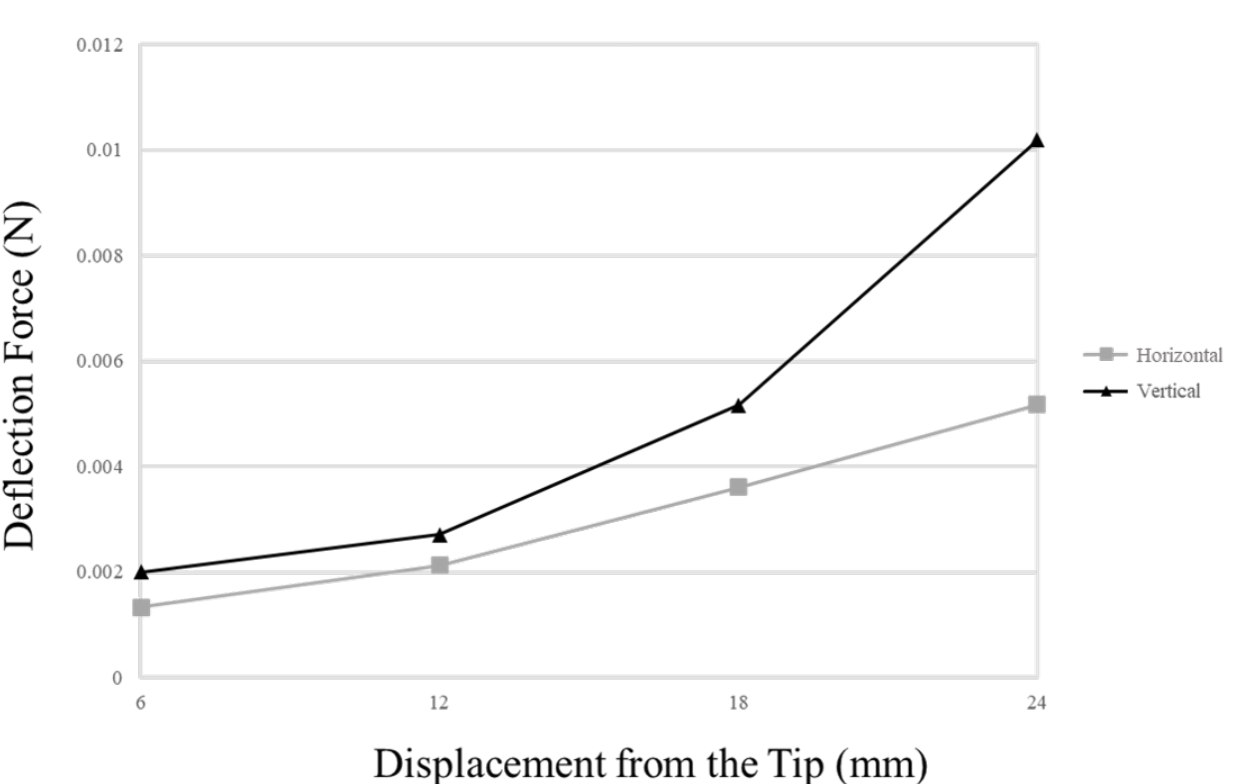
Figure 9. Deflection force measurements of the triple-layer wire bundle in both the horizontal and vertical planes. Deflection forces required to bend the electrode array 30 ◦ from its normal shape were measured at 6 mm increments from the tip to the